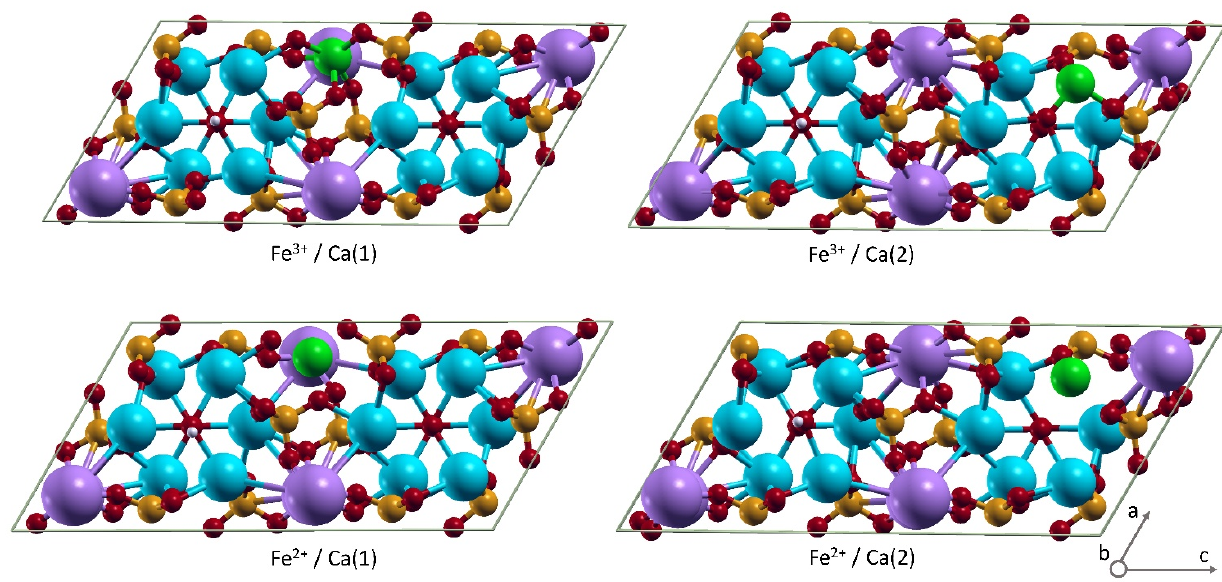
Figure 2. Hydroxyapatite unit cell with iron inclusion in Ca(1) and Ca(2) positions. Color coding: phosphorus—orange, oxygen—red, hydrogen—light grey, Ca(1)—purple, Ca(2)—blue, Fe—green.